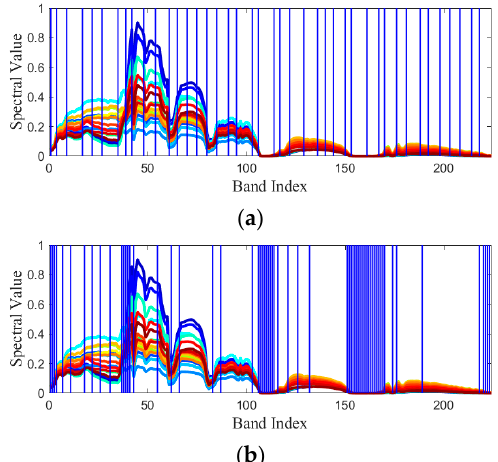
Figure 12. The BG results for the Salinas experiment. ( a ) FNG; ( b ) BD.